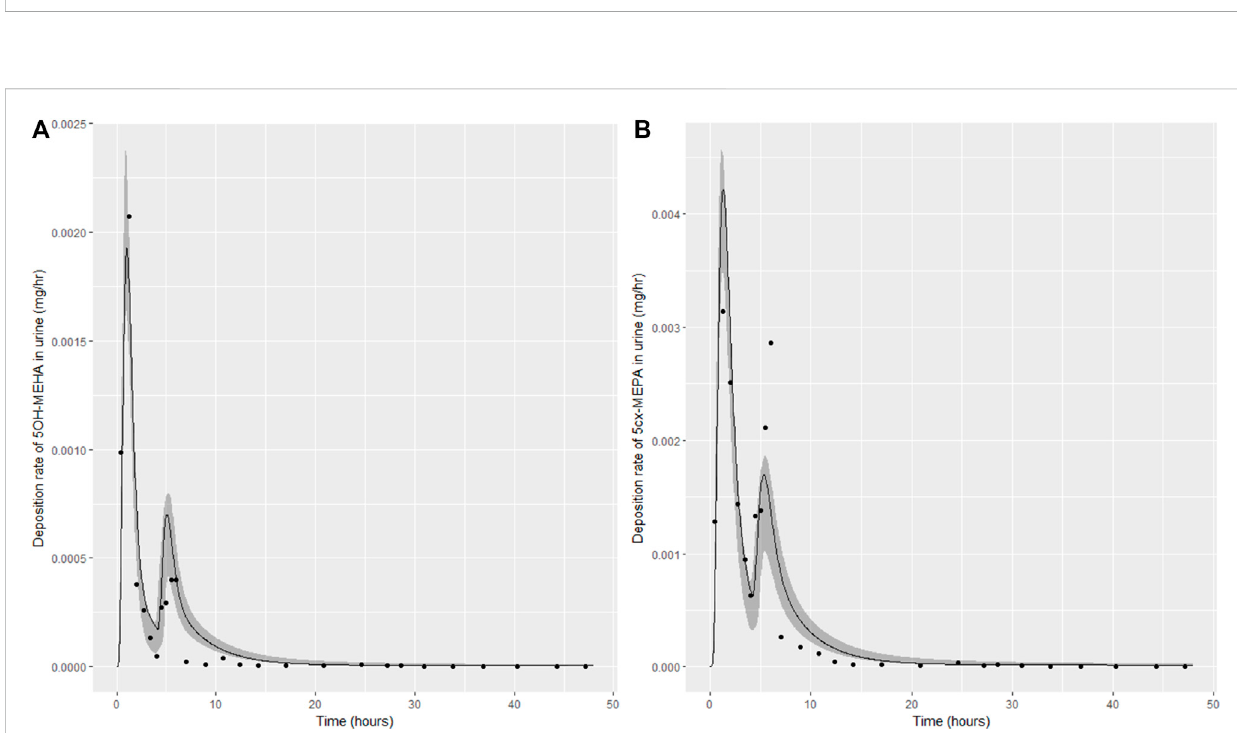
where peak concentrations and the rate of removal varied substantially over the design points. There was no data available for direct comparison against these two measures, however it is